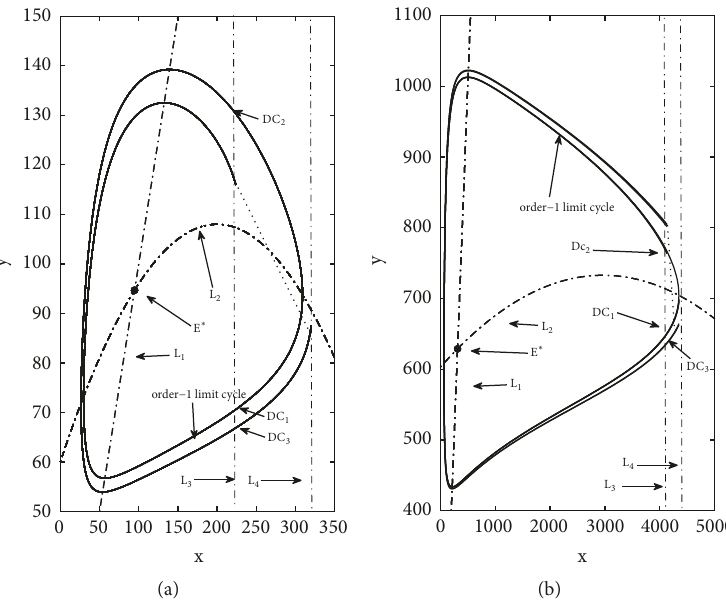
Figure 7: Discontinuity of Poincar´e map. (a) For case (𝑆𝐶 4 ) of system (2) with 𝑟 = 0.3 , 𝐾 = 500 , 𝑚 = 0.5 , 𝐴 = 100 , 𝑠 = 0.03 , ℎ = 1 , 𝐸𝑇 = 3200 , 𝛿 = 0.3 , 𝜎 = 2 , and 𝑞 = 0.3 . (b) For case (𝑆𝐶) of system (2) with 𝑟 = 0.0314425 , 𝐾 = 10000 , 𝑚 = 0.2123448512 , 𝐴 = 4070.34 , 𝑠 = 0.00128 , ℎ = 0.5 , 𝐸𝑇 = 4350 , 𝛿 = 0.05 , 𝜎 = 1 , and 𝑞 = 0.15 . 𝐷𝐶